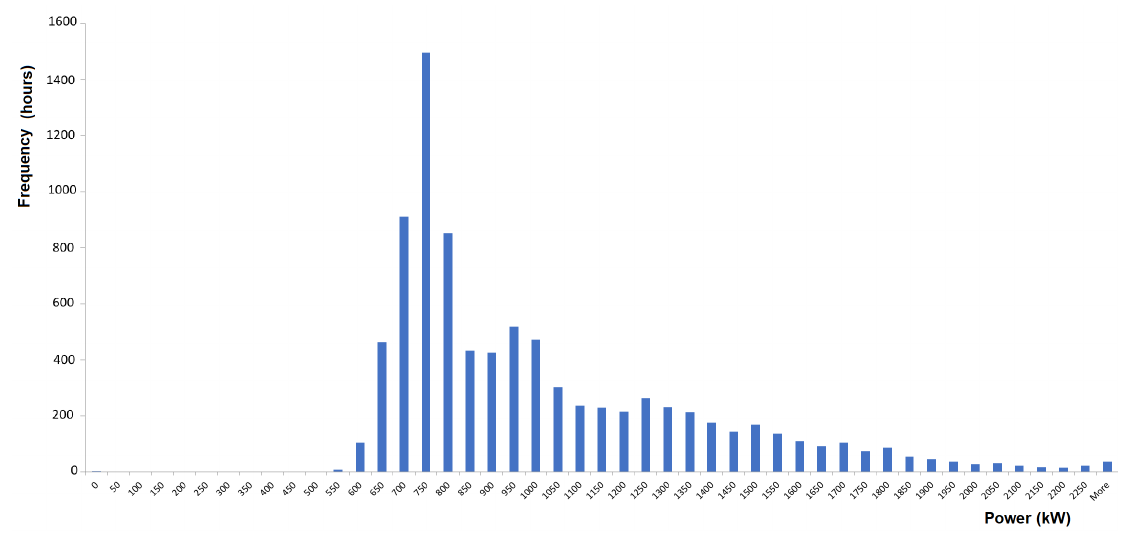
Figure 8. Histogram of power (kW) demanded of the university analyzed (year